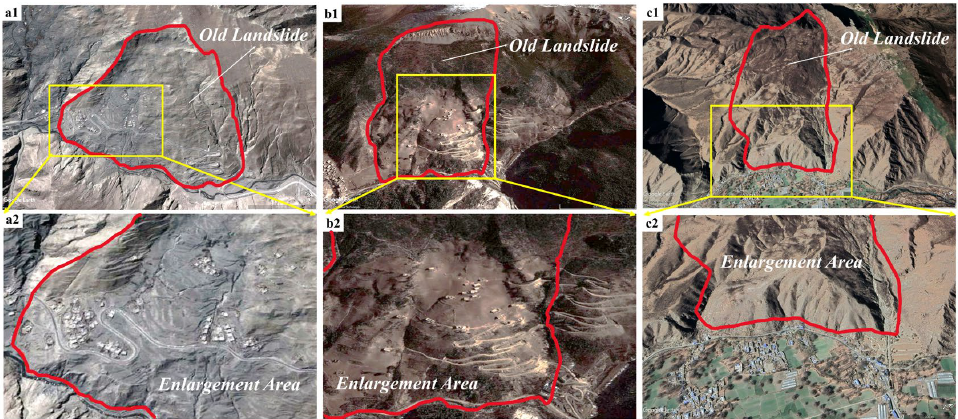
Figure 1. Old landslides and Artificial buildings. ( a1 , a2 ) (29°07′28″ N,92°03′37″ E), ( b1 , b2 ) (29°14′26″ N ,92°12′40″ E), and ( c1 , c2 ) (29°08′48″ N,92°38′17″ E) represent different old landslides, in which ( a2 , b2 , c2 ) show an enlargement area with artificial buildings.